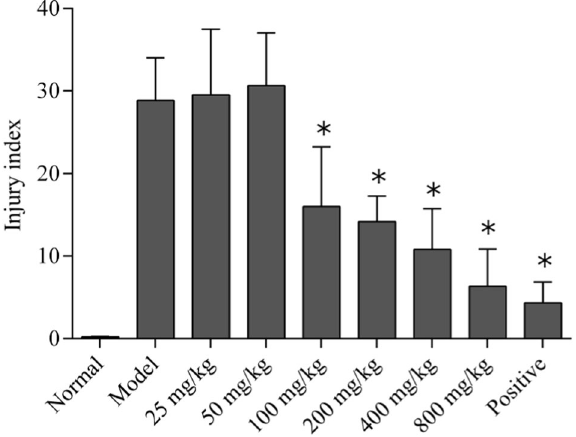
Fig. 2 Effect of L-glutamate on gastric mucosal lesion index in rats induced by aspirin. *Signi fi cantly different from the model at p < 0.01